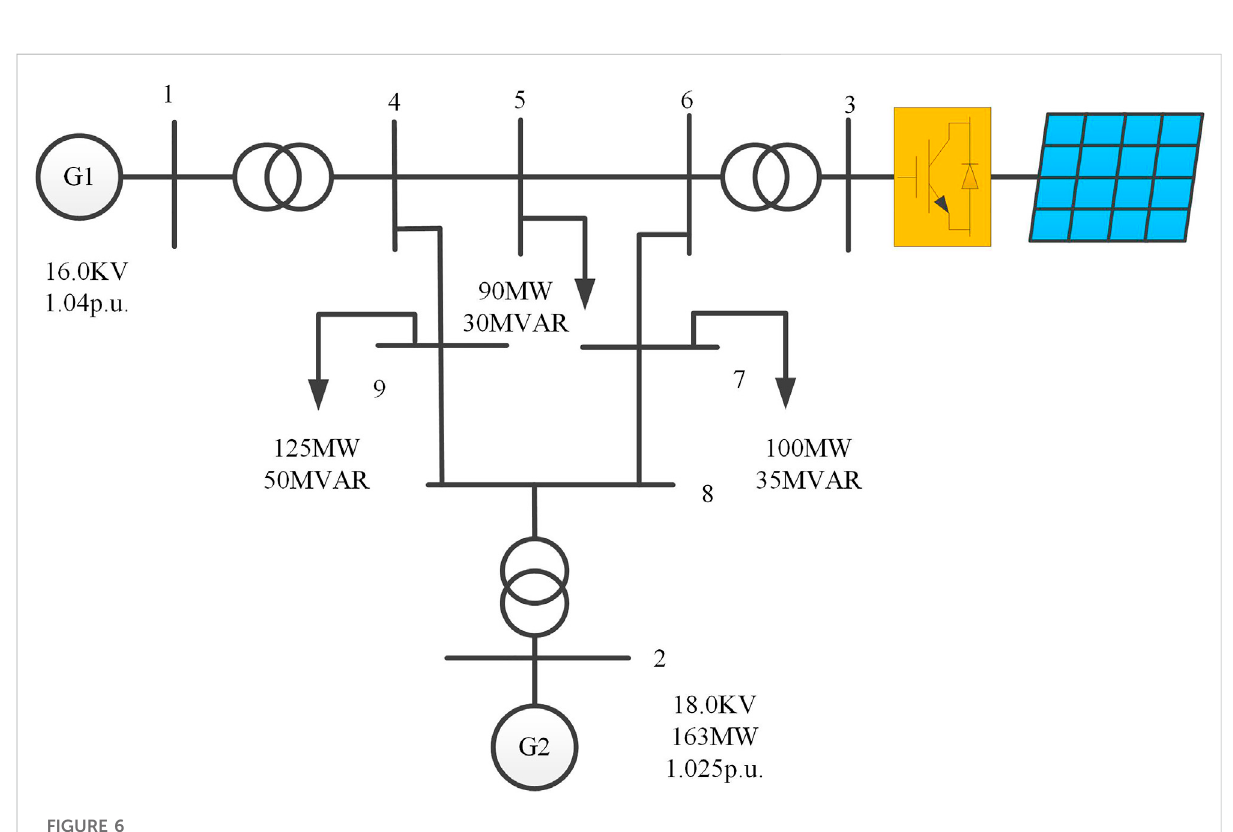
FIGURE 6 Layout of a power system with PV